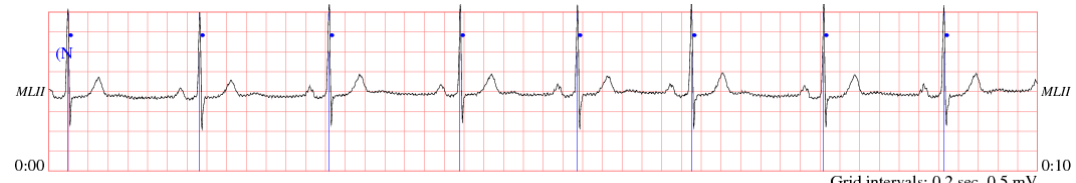
Figure 9. The original ECG data graph.